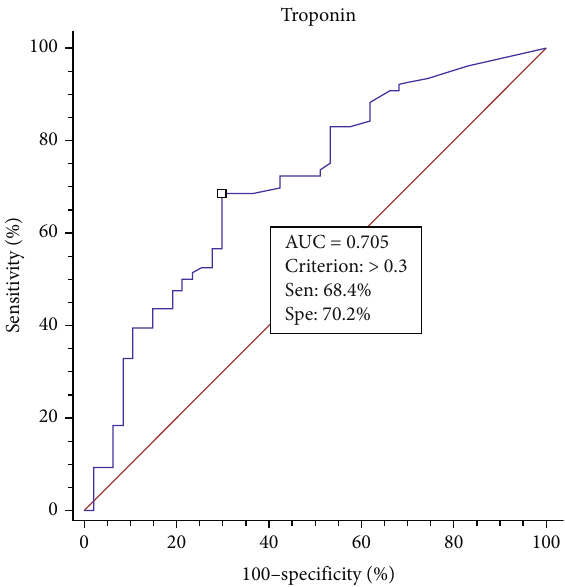
Figure 2: Receiver-operating characteristic curve of troponin I for the diagnosis of non-ST-segment elevation myocardial infarction with type 1 myocardial infarction in patients with sepsis. AUC: area under the curve; Sen.: sensitivity; Spe.: speci fi